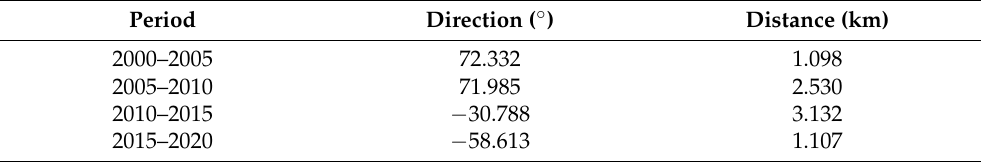
Table 4. Direction and distance of the gravity center’s